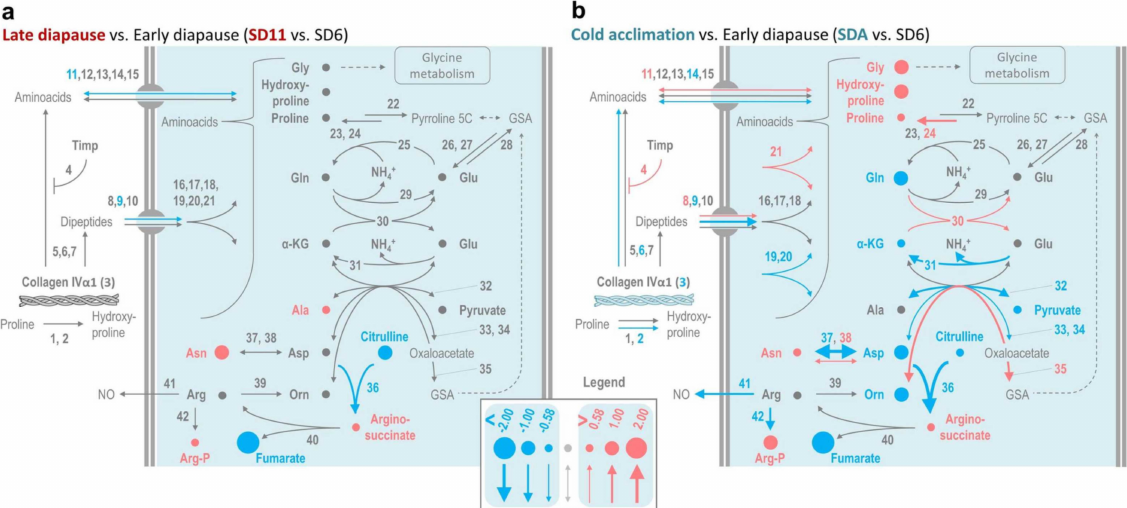
Figure 1. Changes in metabolism of proline during diapause maintenance vs. cold acclimation in C. costata larvae. The maps show log 2 -fold changes in relative concentrations of metabolites (circles) and gene expression (arrows) according to numerical results (Table S4) during diapause maintenance ( a ) and gradual cold acclimation ( b ). Three different thresholds for change were reflected in the size of symbols used (circles and arrows): absolute log 2 -fold change >0.58 (1.5-fold change); >1.00 (2-fold change); and >2.00 (4-fold change). Red indicates upregulation, blue indicates downregulation, grey indicates log 2 -fold changes between − 0.58 to 0.58. Genes are coded by numbers (see Table S3). Thick grey double lines symbolize the plasma membrane with embedded transport systems. α -KG, ketoglutarate; GSA (glutamate-5-semialdehyde) and pyrroline 5C are tautomers and their interconversions are